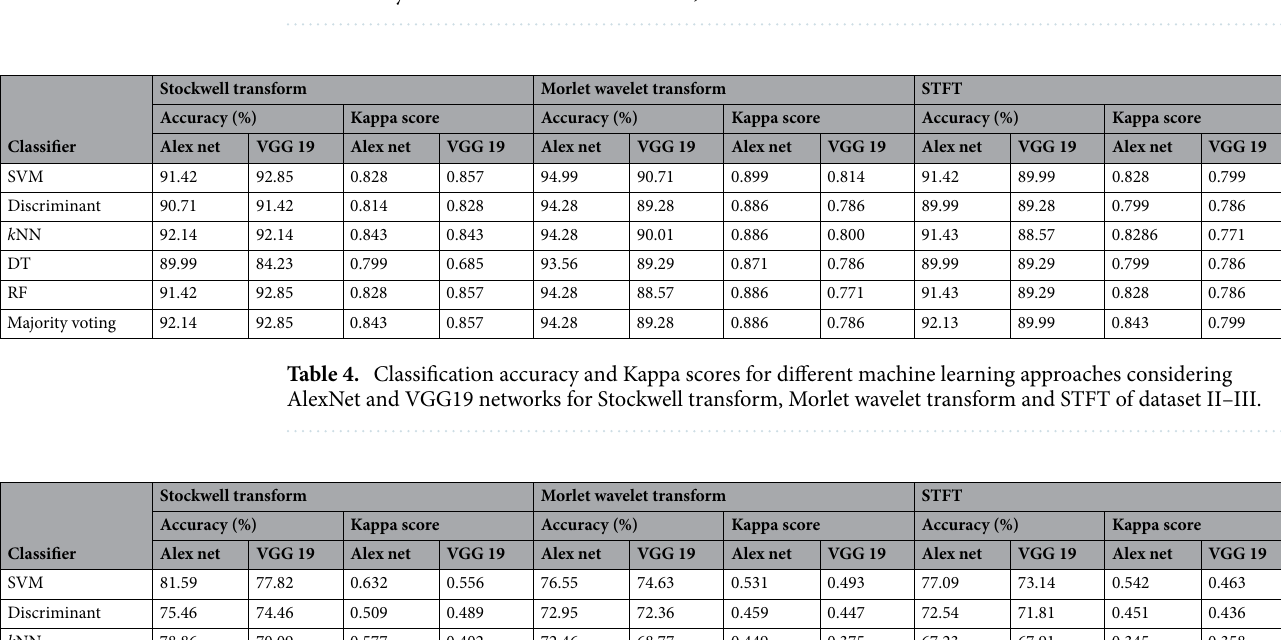
Table 3. Classification accuracy and Kappa scores for different machine learning approaches considering two- and three-layer CNN for Stockwell transform, Morlet wavelet transform and STFT on the dataset IV-2b.